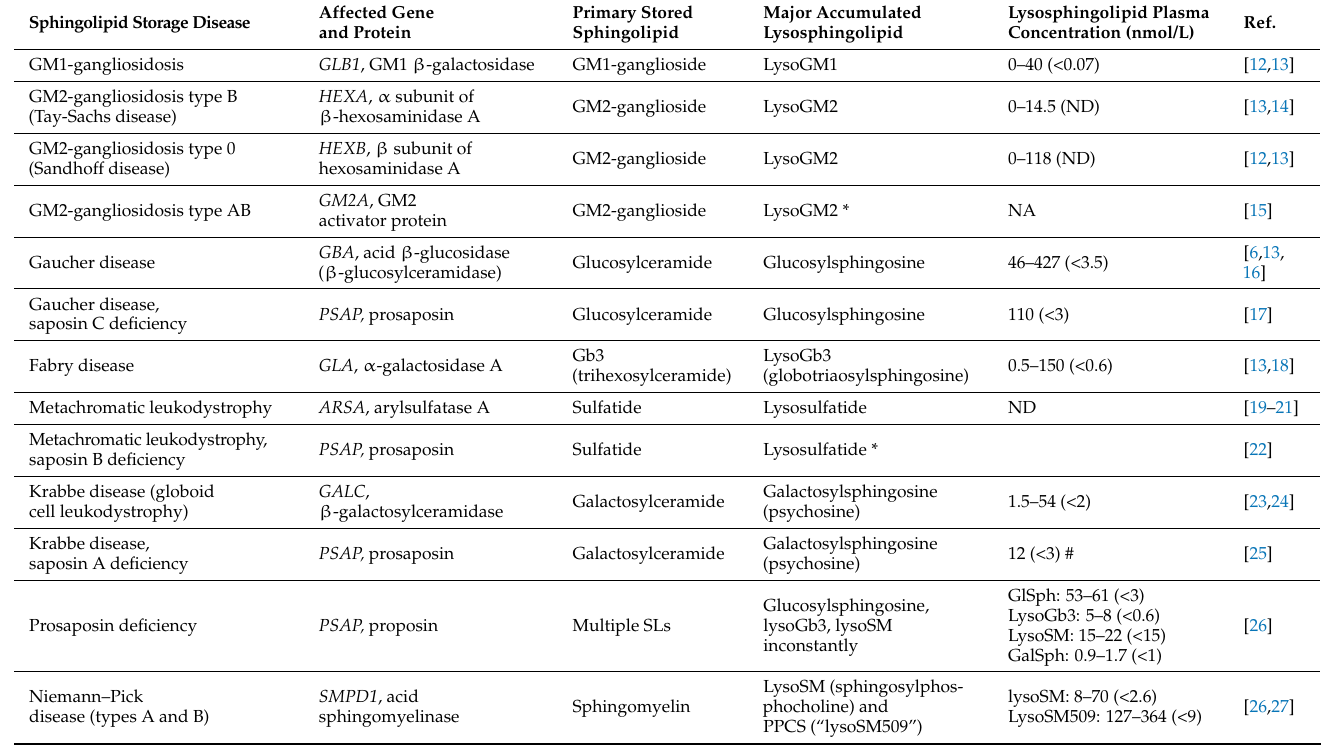
Table 1. Primary accumulated SLs and lysoSLs in sphingolipid storage diseases. Of note, genetic conditions in which the accumulation of some SLs occurs as a secondary phenomenon are not listed here. The plasma concentrations of lysosphingolipids are indicated in brackets (control